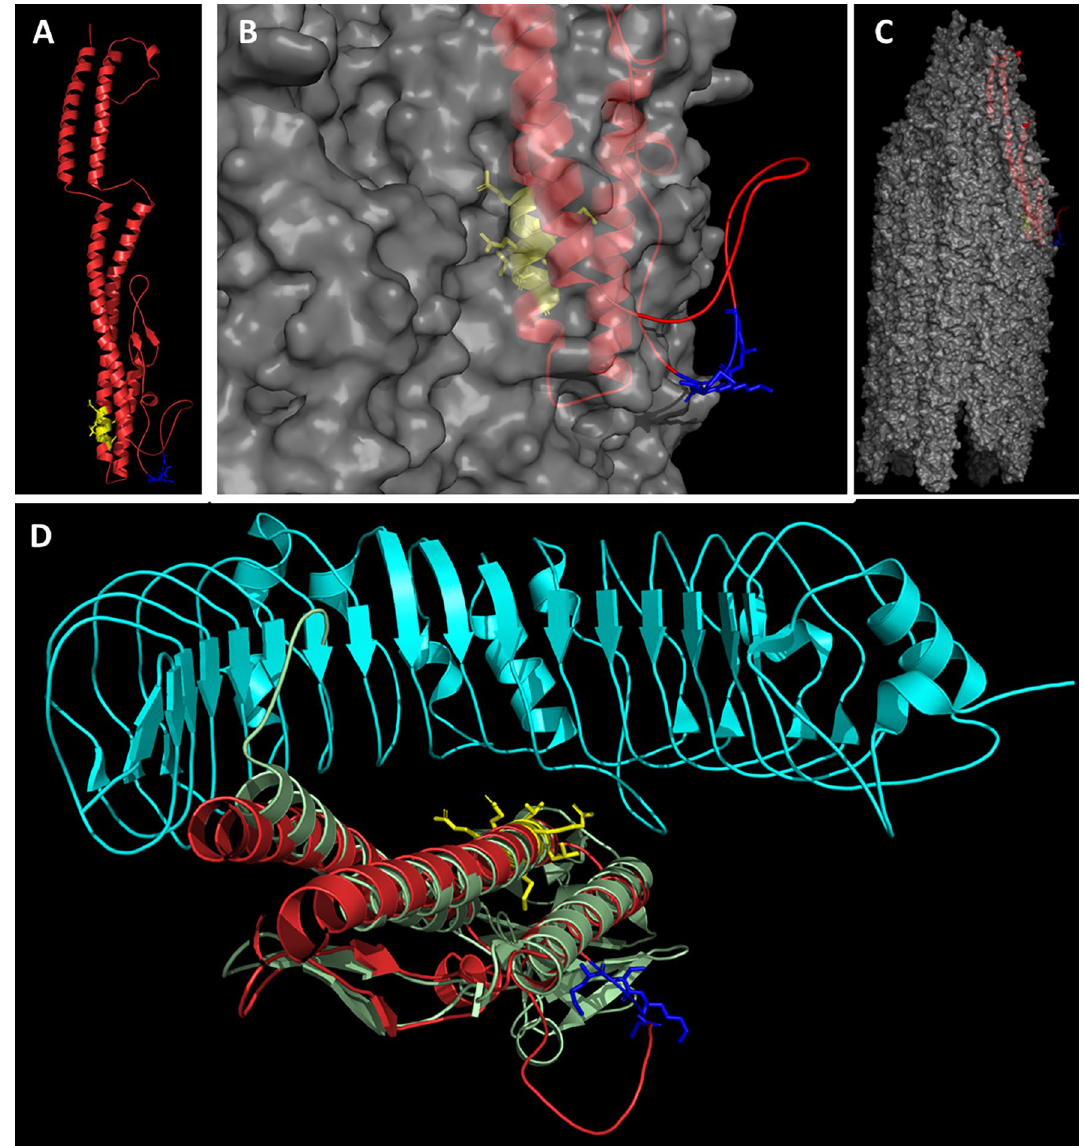
Figure 6. Modelling of C. difficile flagellin. ( A ) Secondary structure of FliC monomer. 205 MSKAG 209 epitope is indicated in blue. 117 QRMRTLS 123 epitope is indicated in yellow. ( B , C ) The FliC multimer which forms flagella body. ( D ) The interaction between TLR5 molecule (cyan) and FliC (green Salmonella FliC; red CD FliC). 117 QRMRTLS 123 epitope indicated in yellow in the center of the